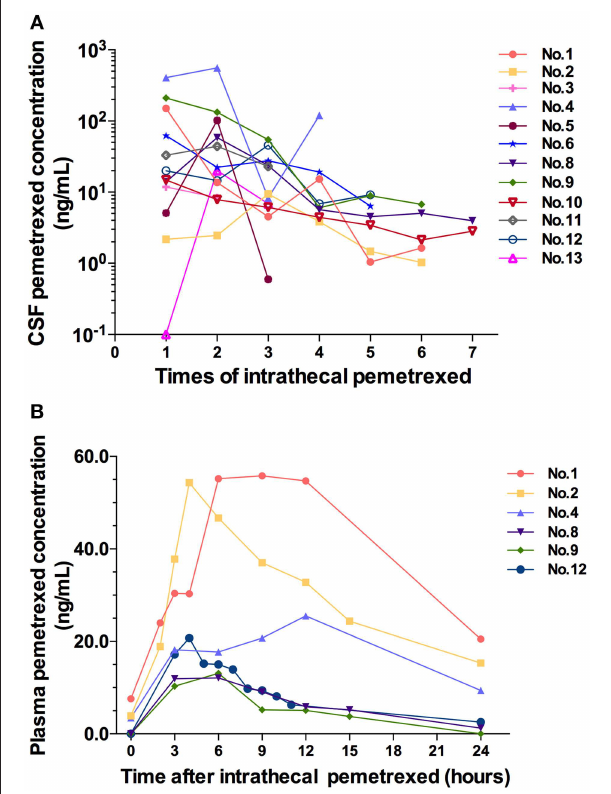
FIGURE 3 | (A) CSF pemetrexed concentration after each time of intrathecal pemetrexed. (B) Plasma pemetrexed concentration at different time points after intrathecal pemetrexed. No, patient